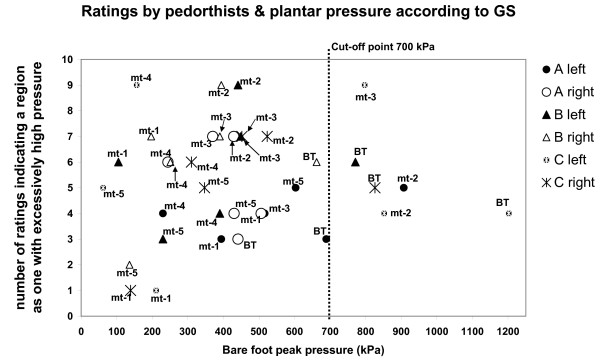
Ratings by pedorthists. The distribution of ratings of pedorthists who indicated a region as one with excessively high pressure, against the plantar pressure measured with the pressure platform (Gold Standard).